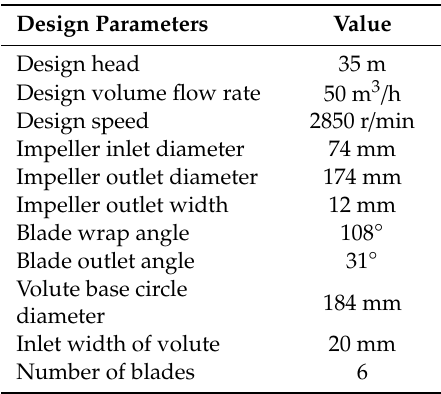
Table 1. Main design parameters of a centrifugal pump.